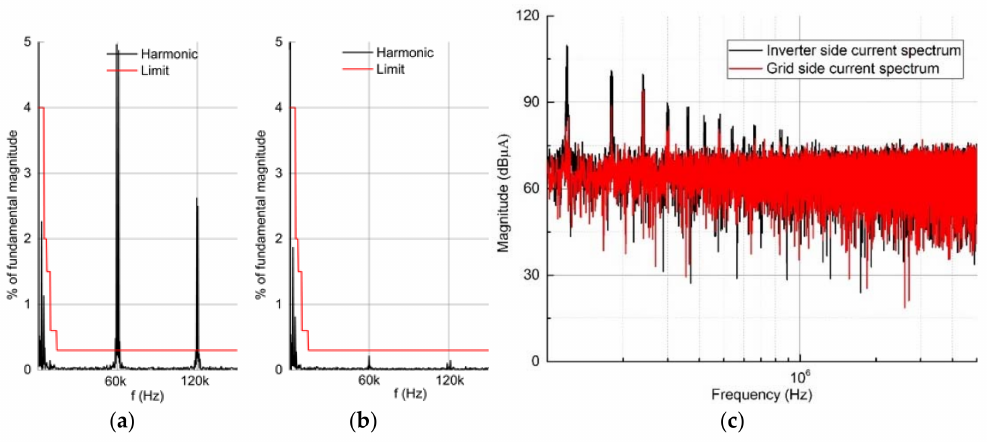
Figure 12. Harmonic distortion of the measured current with the copper wire winding: ( a ) inverter side; ( b ) grid side; and ( c ) reduced current spectrum at the grid side.